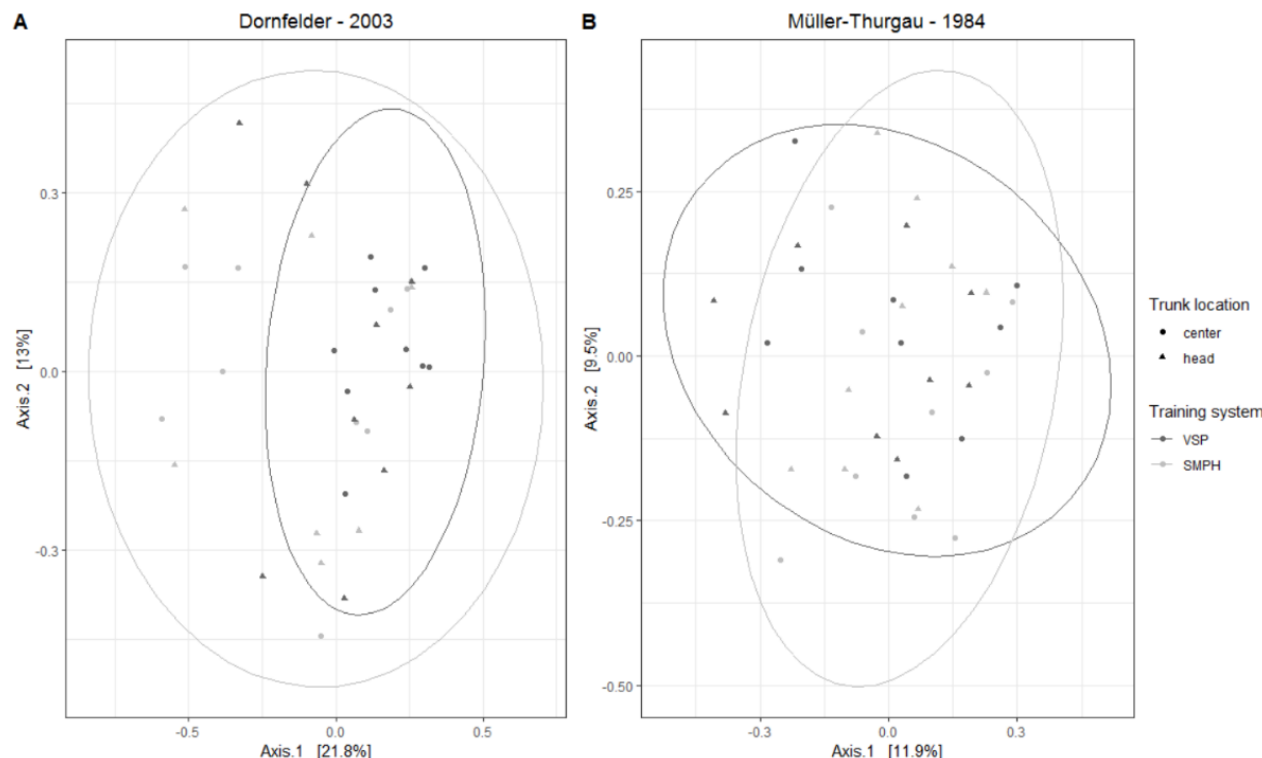
Figure 6. PCoA based on Bray–Curtis dissimilarities of the wood samples collected from the ( A ) ‘Dornfelder’ and ( B ) ‘Müller-Thurgau’ vineyards. Samples were grouped by origin, i.e., trunk center (●) and trunk head ( ▲ ), and training system, i.e., VSP (dark) and SMPH (bright). Ellipses represent 95% confidence intervals for the mycobiome from each group (training system).